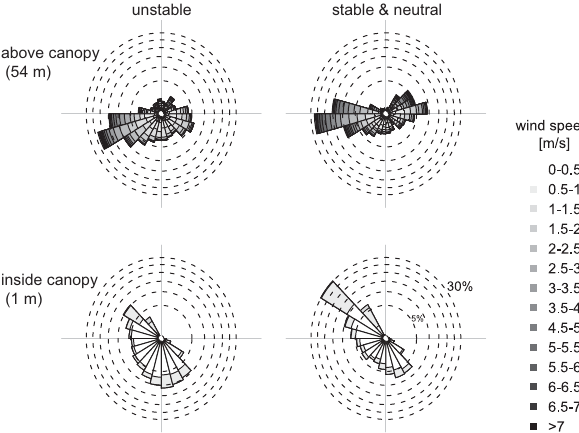
Fig. 3. Wind roses for above (54m) and inside the canopy (1m) for two stability classes (stable & neutral: z / L > = 0, unstable: z / L < 0). Each broken circle refers to 5% frequency classes in the respective wind direction sector. Data were measured during May to August